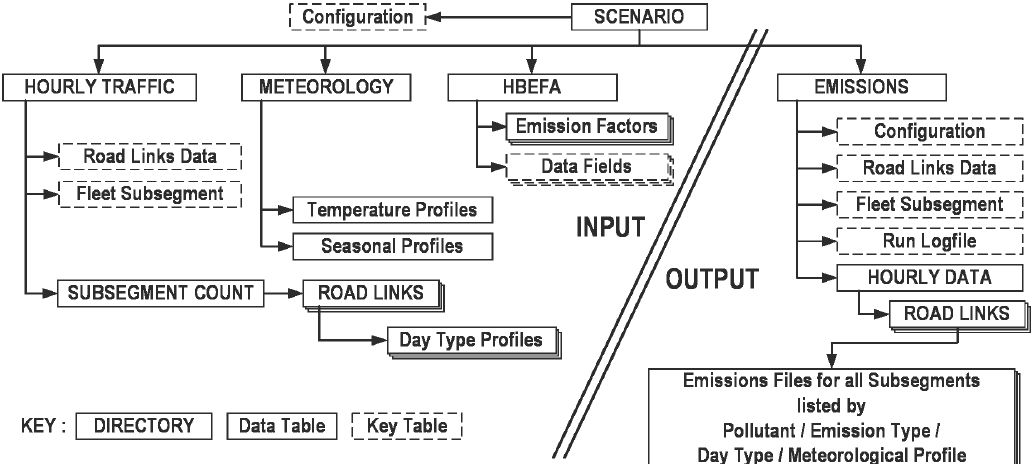
Figure 1. Data requirements and organization of Yeti.